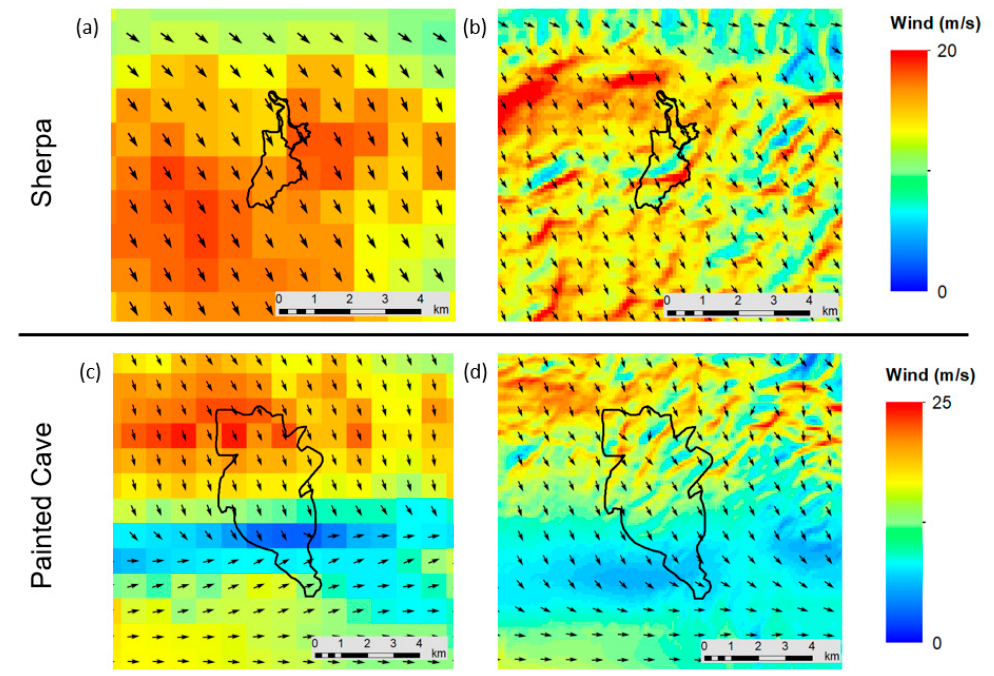
Figure 3. Examples of gridded wind data from WRF at 1 km resolution ( a , c ) and WN at 100 m resolution ( b , d ) at the time of ignition for the two wildfire case studies. It’s important to note that output is at 10 m (~30 ft) for the WRF surface winds and at 6.1 m (20 ft) for WN surface winds used in this analysis. The black polygons are the fire perimeters at 1600, 1800, and 1900 PDT for the Sherpa Fire, and the final perimeter for the Painted Cave Fire.